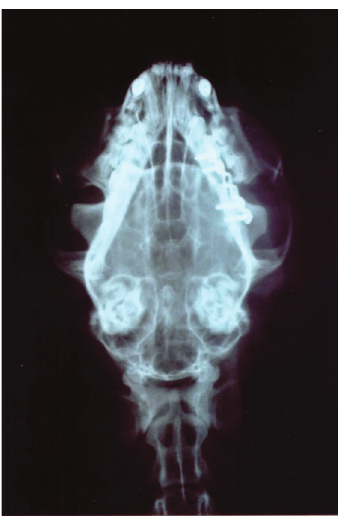
FIGURE 7 - Intraoral radiograph taken 1 week after surgery shows the segmental defect filled with autogenous bone graft. Cat 20 of Group